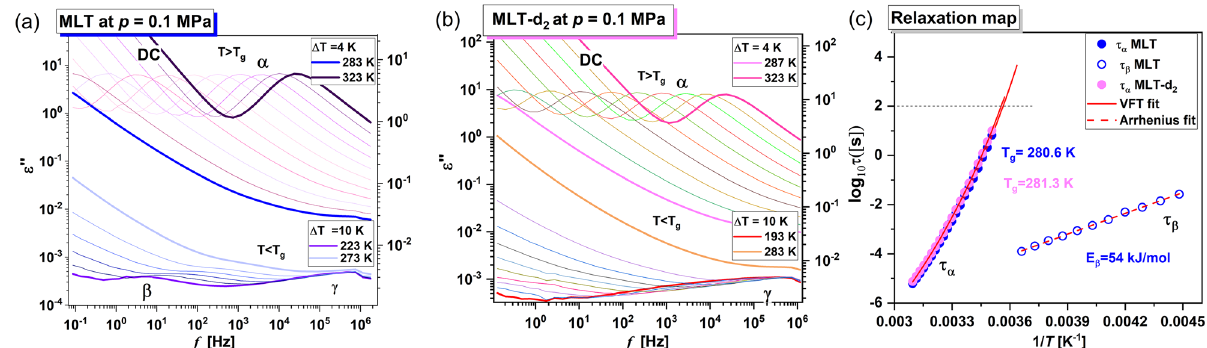
Figure 4. Dielectric loss spectra measured for MLT ( a ) and MLT-d 2 ( b ) at ambient pressure, in a wide temperature range, above and below the T g . Panel ( c ) presents a relaxation map for both examined compounds. Solid and dashed red lines are VFT and Arrhenius fits,